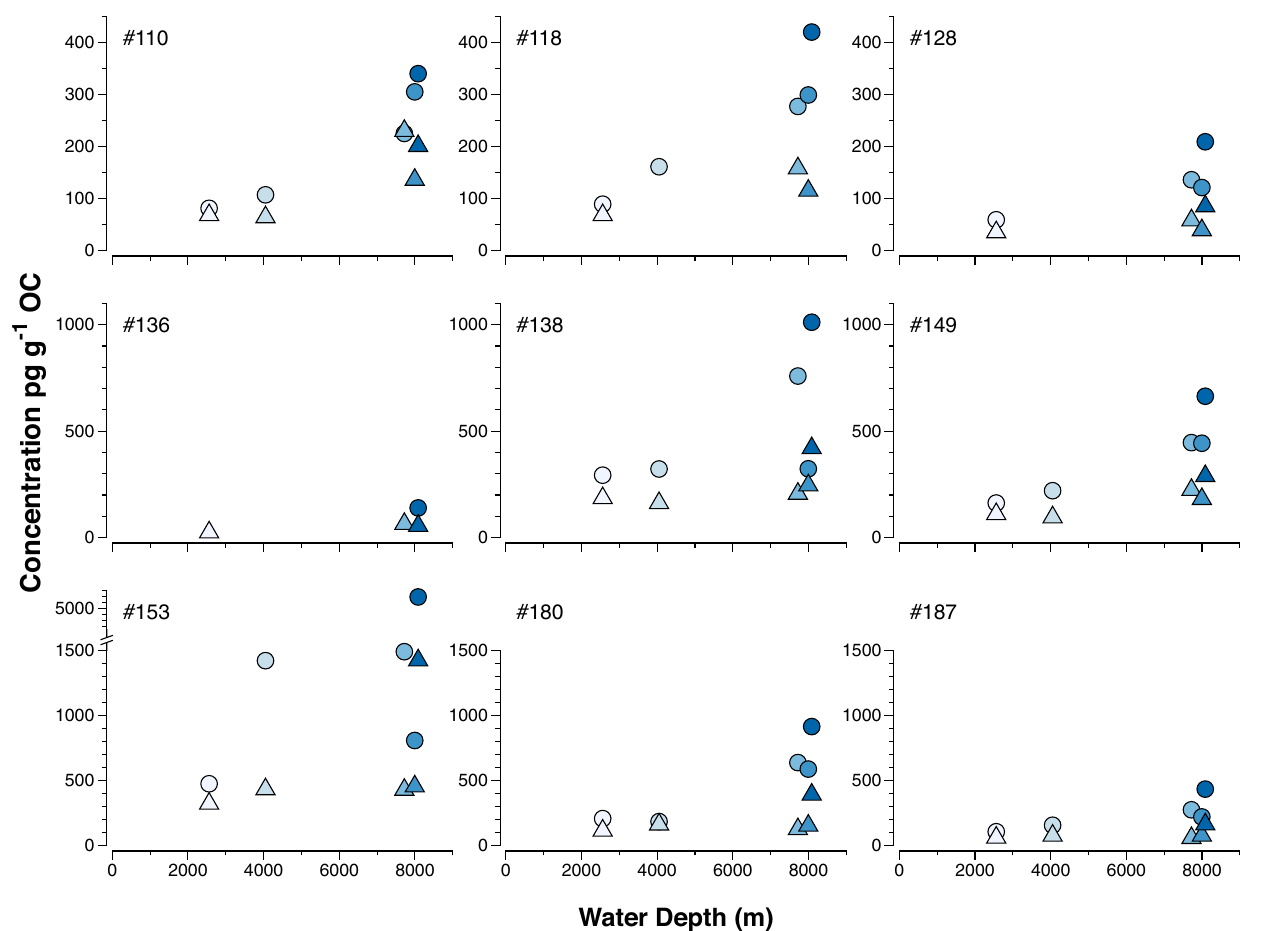
Fig. 4 | Concentrations of nine polychlorinated biphenyl (PCB) congeners in pg g − 1 organic carbon (OC) in Atacama sediment (upper 40mm) versus water depth. Sediment concentrations in layer 0 – 20mm are depicted by circles and in